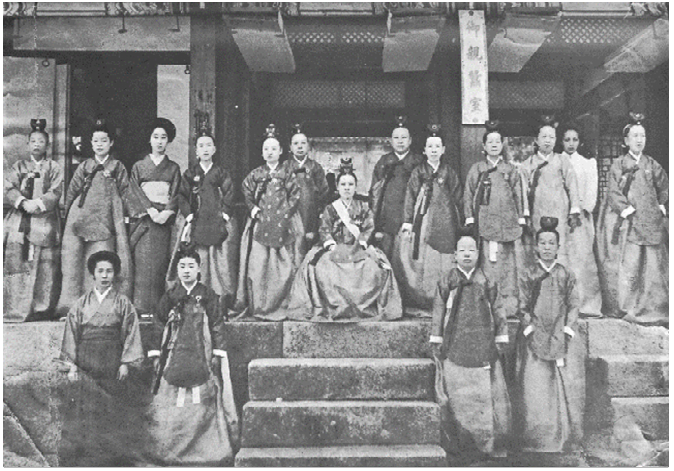
Figure 21. Queen (center) and court ladies, including Ch’ŏn Ilch’ŏng to her right, on the day of the Queen’s sericultural ceremony at Sŏhyanggak of Ch’angdŏkkung. After (Kim 1987, n.p.).